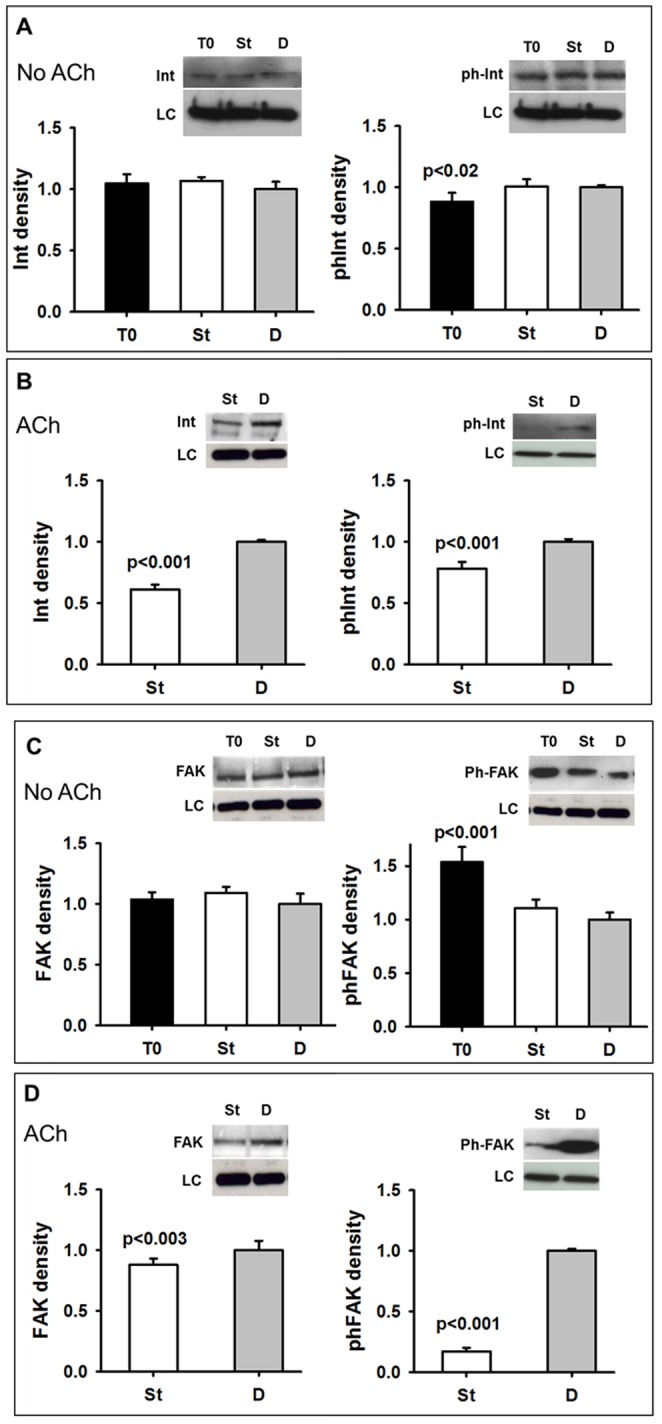
Tidal stretch increases the level and activity of integrin-β1 and activates its signaling partner FAK during contraction.Western blots are shown for integrin-β1 (Int, ∼140 KDa) and its phosphorylated form (ph-Int) (A and B) and for focal adhesion kinase (FAK, ∼125 KDa) and its phosphorylated form (ph-FAK) (C and D) in intact bovine airways after 90 min of mechanical loading with (B and D) or without (A and C) constriction. T0: time 0 before stretch, St: static Ptm. D: dynamic Ptm oscillation. GAPDH (∼35 KDa) is loading control. Data are normalized such that the mean of the dynamic group is unity.